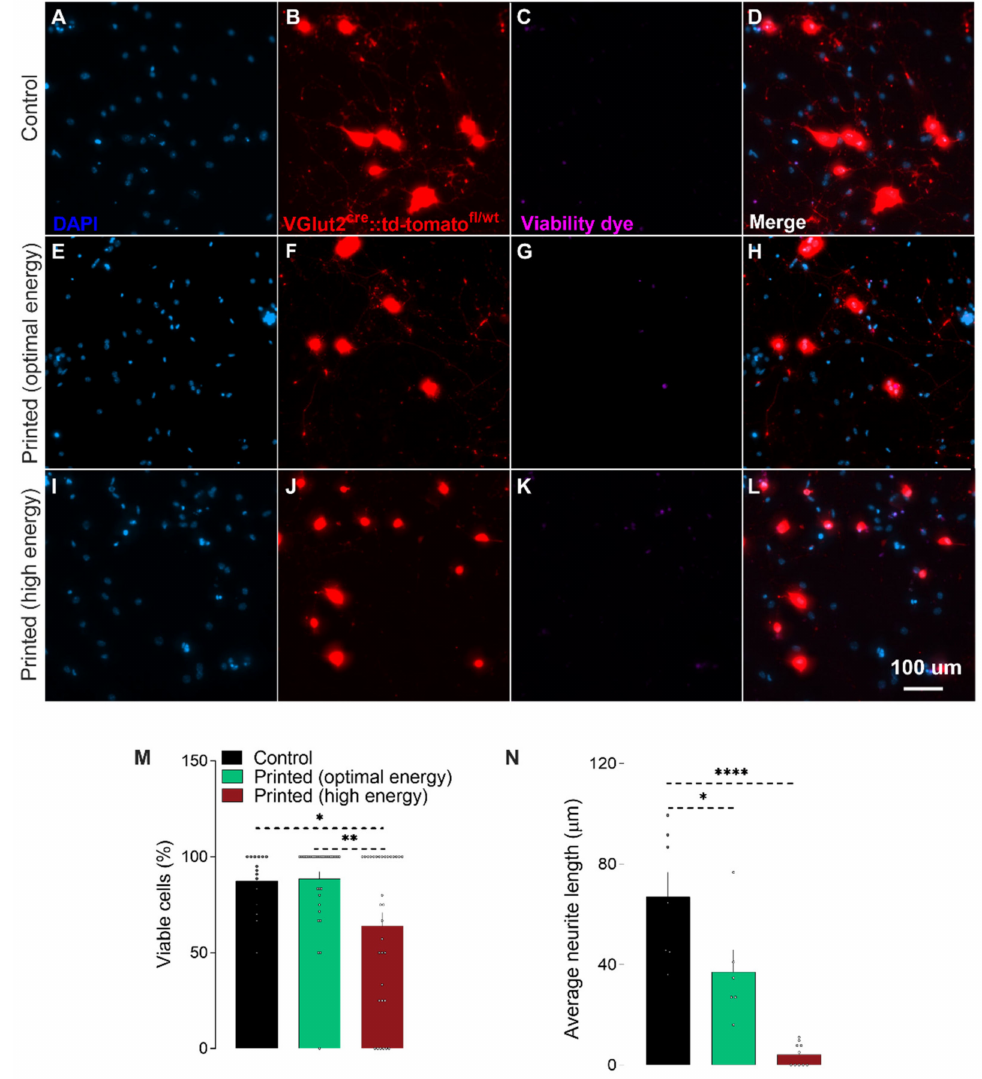
Figure 2. Bioprinting does not impact DRG neurons’ survival, but reduces neurite outgrowth. Representative fluorescence images of adult VGlut2 cre ::td-tomato fl/wt DRG neurons mice printed with low (100 µ J, E – H ) or high energy (120 µ J, I – L ) or put in cell culture (control, A – D ). Percentage of viable cells 2 days post-printing ( M ; determined as fixable Viability Dye eFluor™ 780 - ) and average neurite length ( N , in µ m). Results consist of the means ± S.E.M. One-way ANOVA with Tukey’s multi comparisons test. Significant differences in M and N are indicated by asterisks ( p < 0.05 = *; p < 0.01 = **; p < 0.0001 = ****). Nucleus (Blue; A , E , I ), VGlut2 cre ::td-tomato fl/wt neurons (red; B , F , J